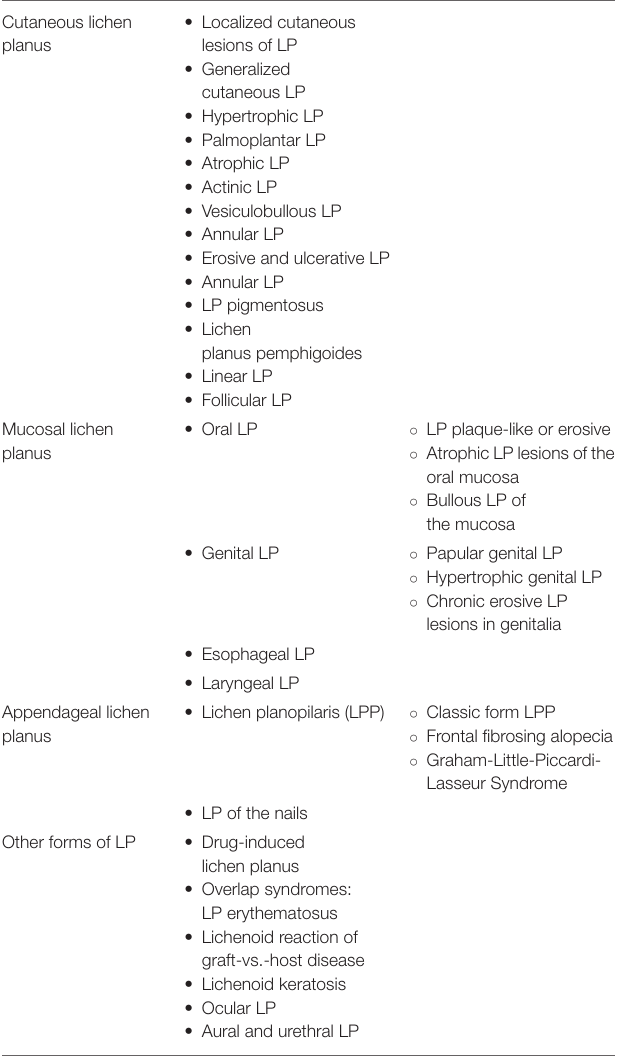
TABLE 1 | Overview of clinical subtypes and rare variants. Cutaneous lichen